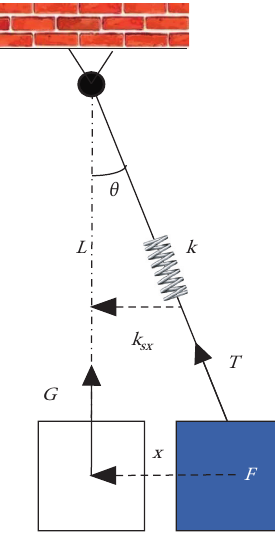
Figure 2: The theoretical model of rope